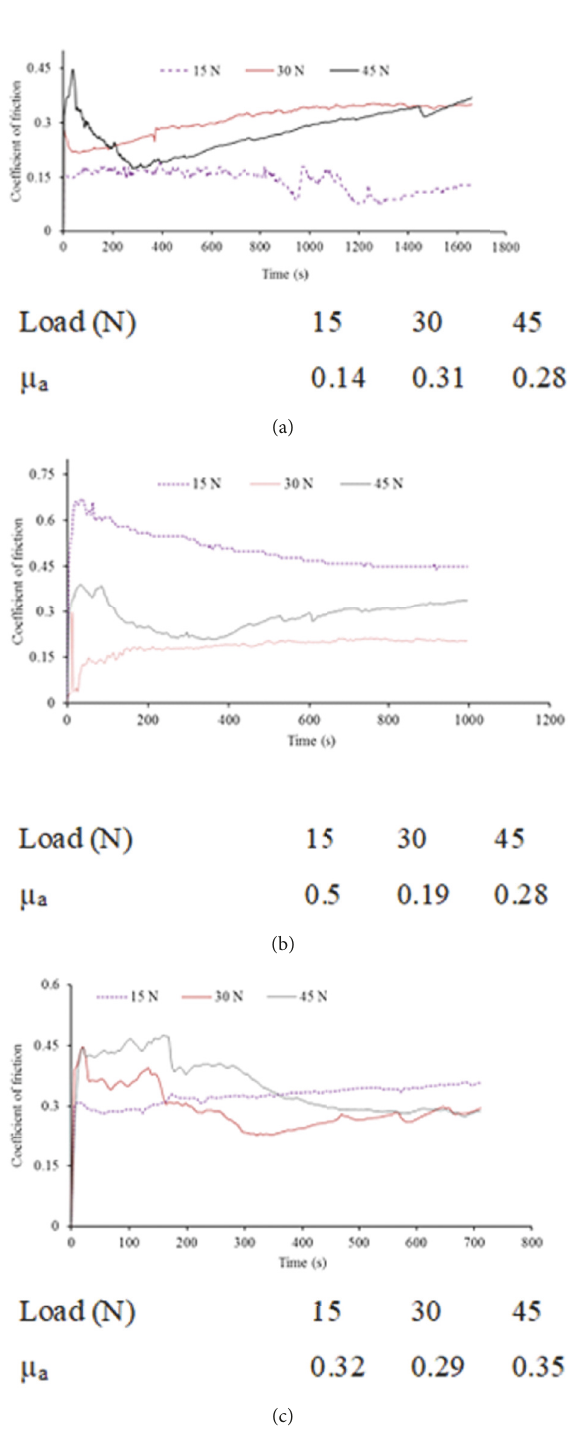
Figure 6: Coefficient of friction plots and average coefficient of friction of CF/E composites at sliding speed (a) 1.5 m.s −1 , (b) 2.5 m.s −1 , and (c) 3.5 m.s −1